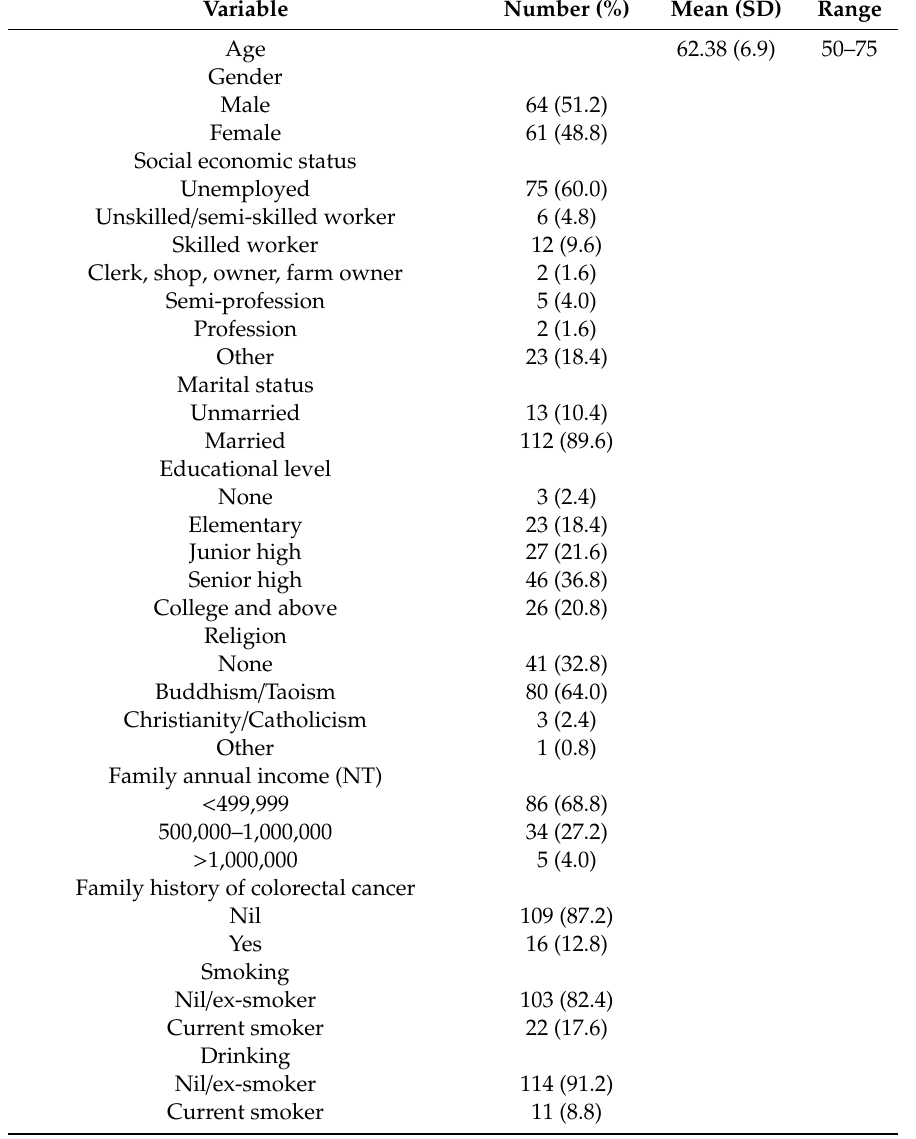
Table 1. Demographic and health characteristics of subjects (N =